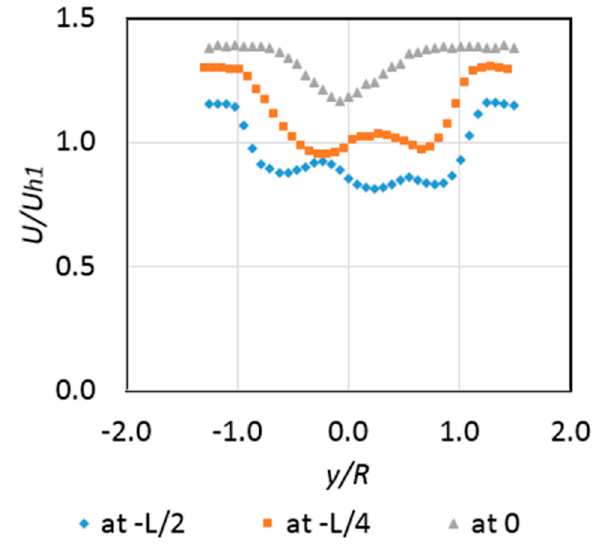
Figure 9. Configuration B: Horizontal wind speed profiles upstream of the hill.